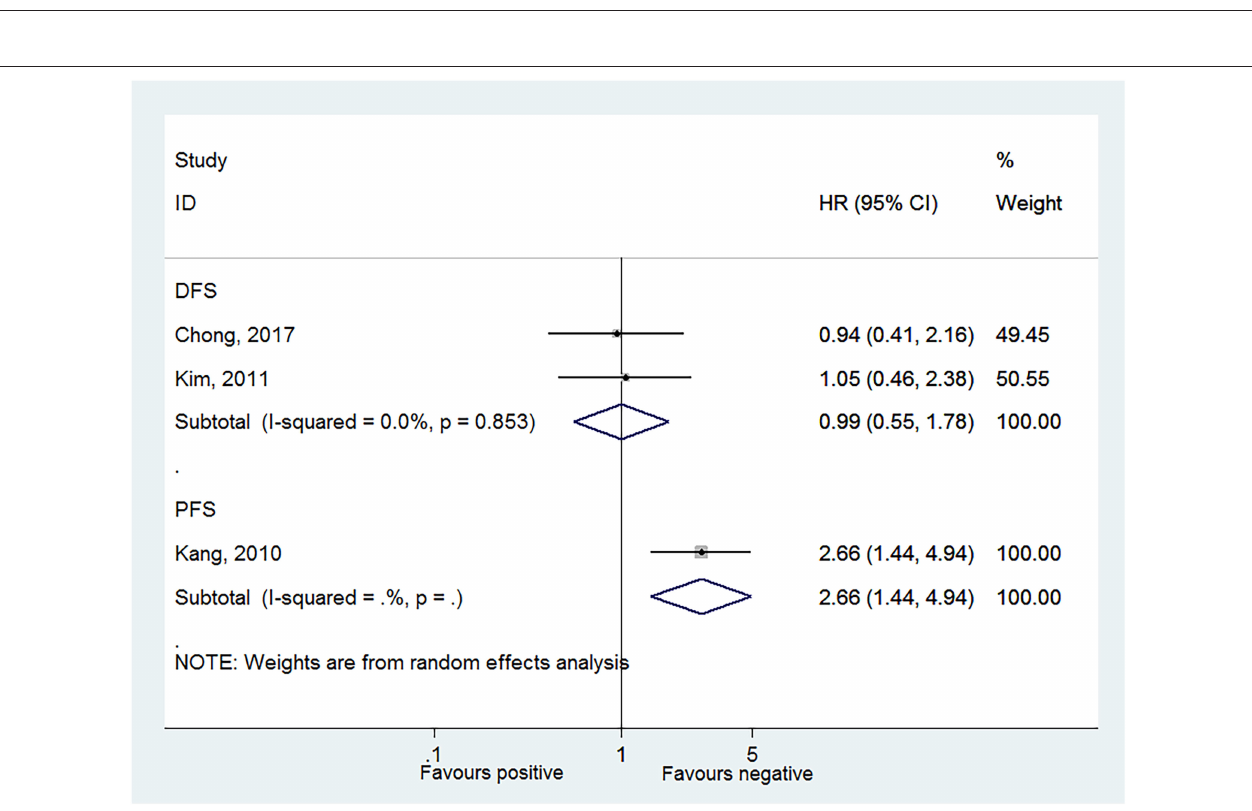
FIGURE 4 | Forest plot of disease-free survival and progression-free survival comparing the human papillomavirus subtype 18 (HPV-18) positive vs. negative groups.